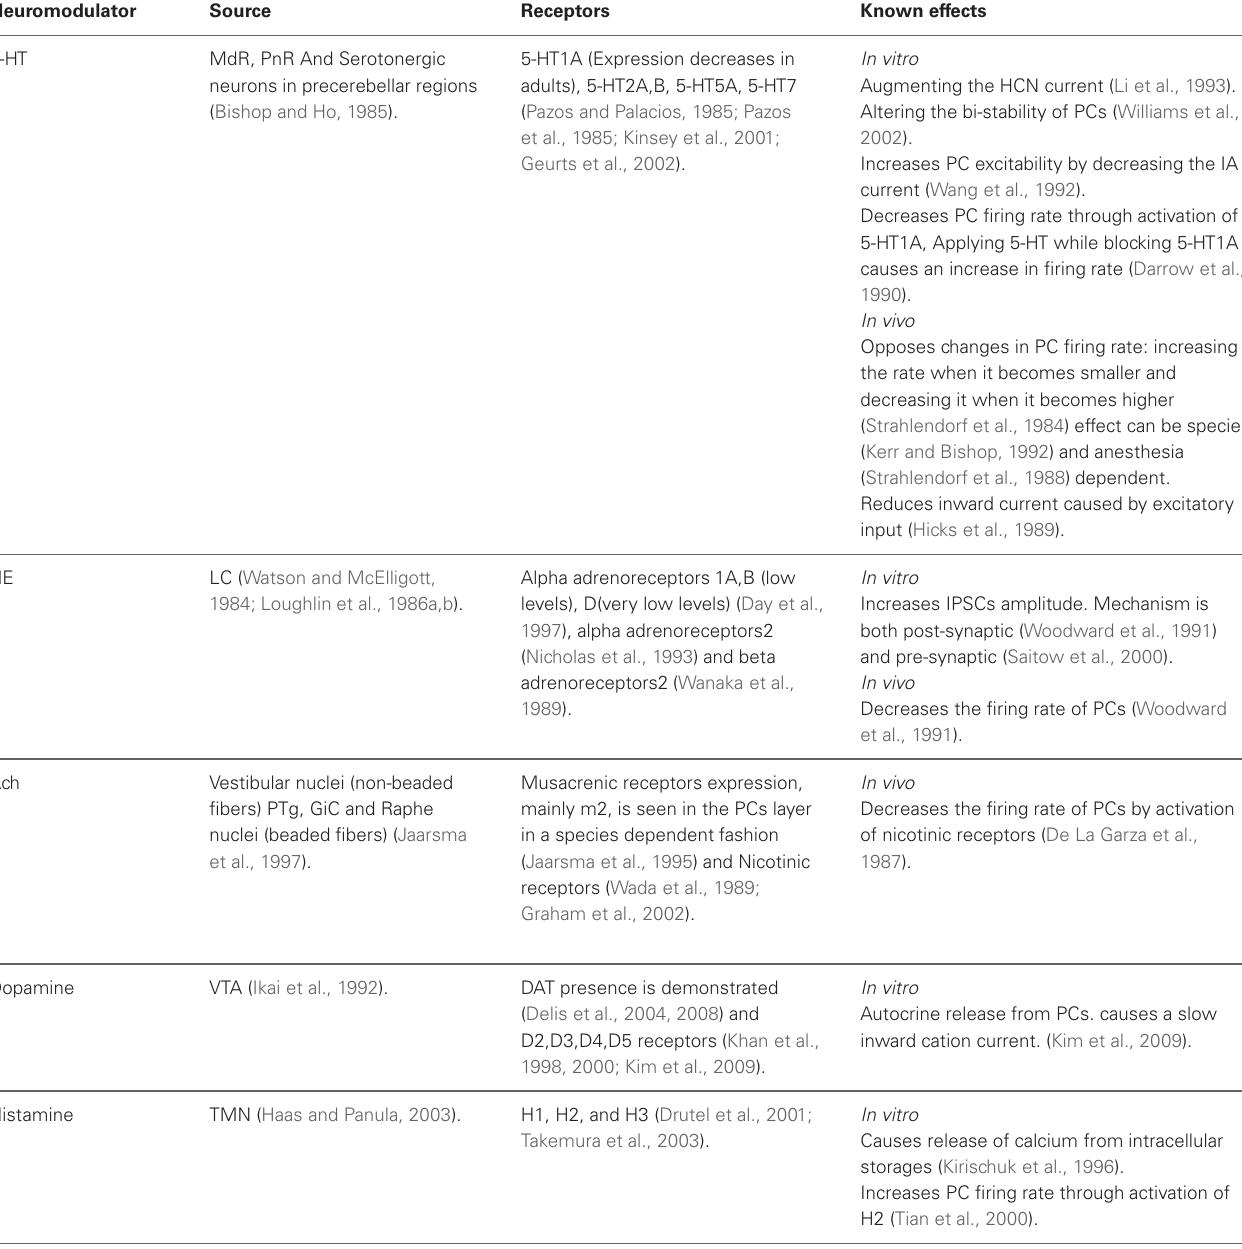
Table 2 | Neuromodulators of Purkinje